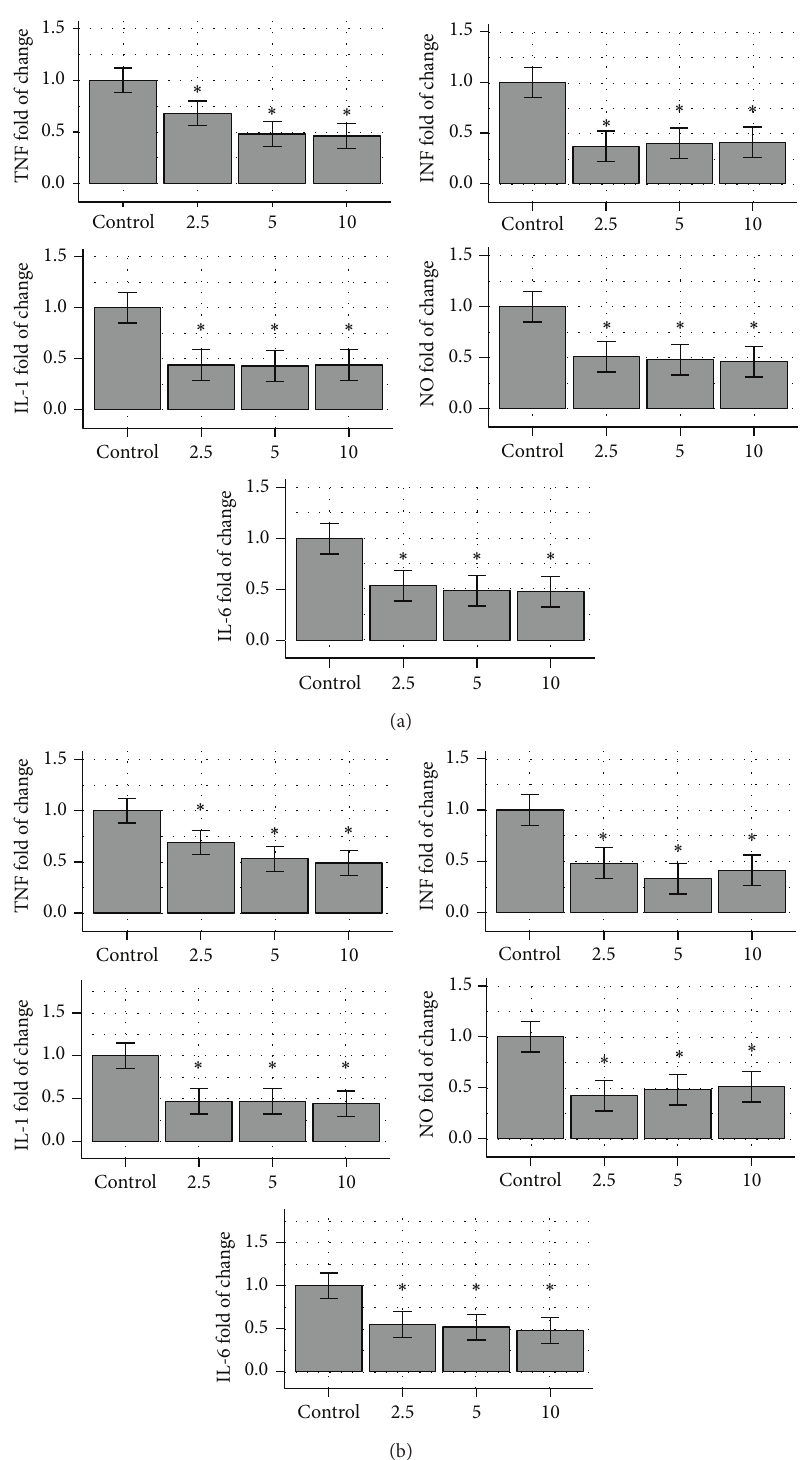
Figure 1: (a) A graphic representation of Table 1. The 1a indicates the reduction from the control of RAW264.7 macrophages inflammatory response of TNF, IL-1, IL-6, INF, and NO, respectively, in the presence of 0, 2.5, 5, and 10ng/mL Torin. The graphs are depicted as a percent of the control response, that is, without Torin (0ng/mL). TNF: tumor necrosis factor, IL-1: interleukin 1, IL-6: interleukin 6, INF: interferon, and NO: nitric oxide. (b) It is a graphic representation of Table 1. The 1b indicates the reduction from the control of RAW264.7 macrophages inflammatory response of TNF, IL-1, IL-6, INF, and NO, respectively, in the presence of 0, 2.5, 5, and 10 ng/mL KU63794. The graphs are depicted as a percent of the control response, that is, without KU63794 (0 ng/mL). TNF: tumor necrosis factor, IL-1: interleukin 1, IL-6: interleukin 6, INF: interferon, and NO: nitric